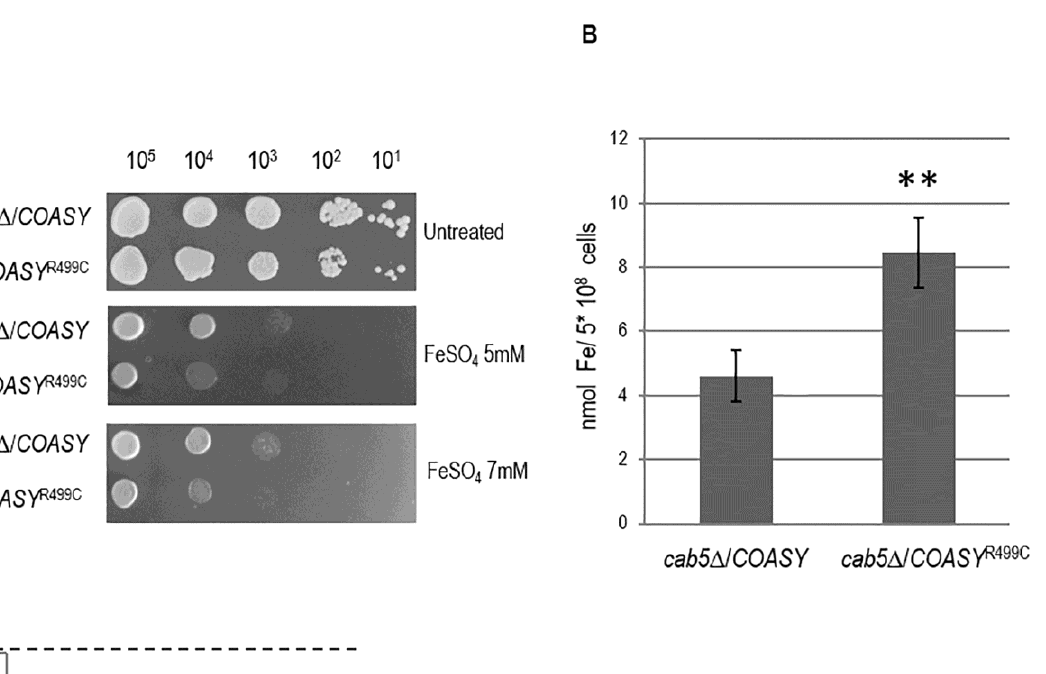
FIGURE 3: Measurement of iron content. (A) Iron